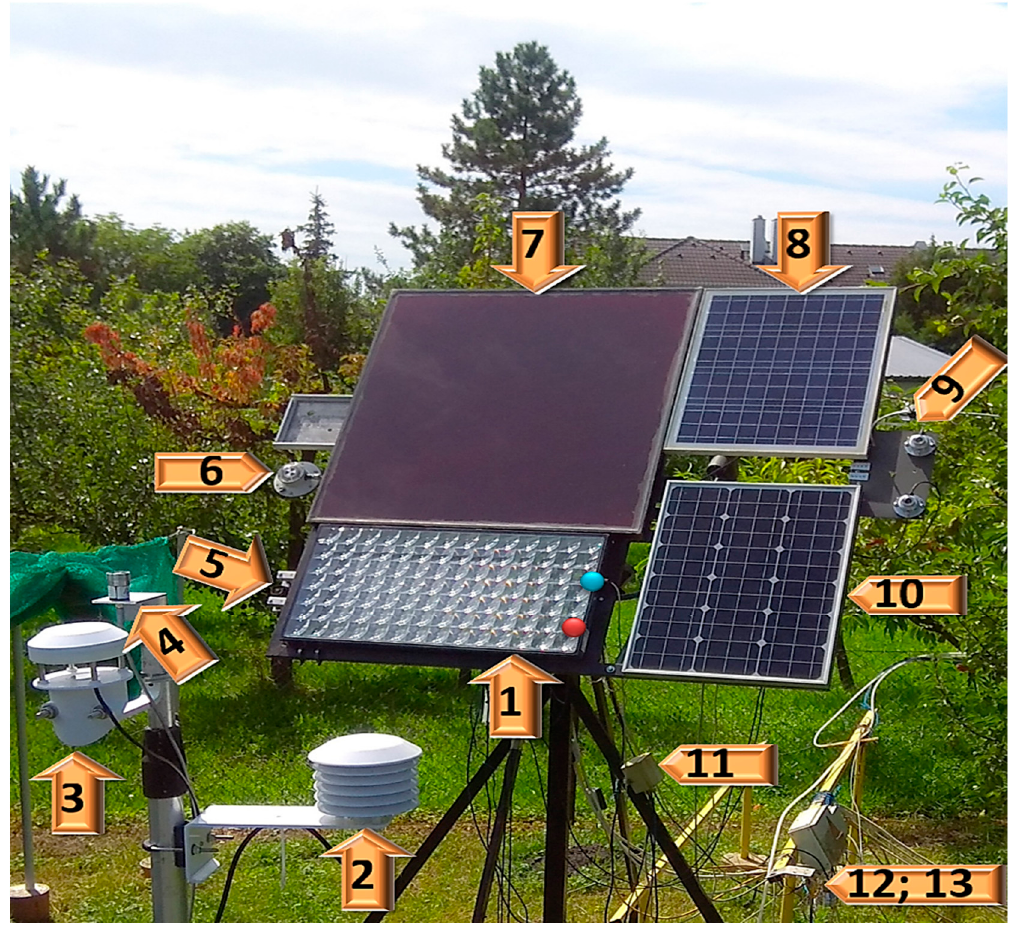
Figure 3. The photovoltaic (PV) testing station of the University of Pannonia in Hungary, Keszthely (1. CPV module, 2. OTT TRH relative humidity sensor; 3. DS-2 Sonic anemometer, 4. EMS 11 Silicon PV detector, 5. photosensors, 6. Eppley Black and White pyranometer, 7. a-Si module, 8. p-Si module, 9. Hukseflux LP02 pyranometers, 10. m-Si module, 11. manual/automatic tracking control unit, 12. HYTE-ANA-1735 humidity module [measuring air humidity], 13. Pt 100 sensor [measuring air temperature]; Blue dot: Pt 100 sensor [measuring the temperature of the air inside the CPV module]; Red dot: Pt 100 sensor [measuring the CPV module’s cell temperature at the rear].